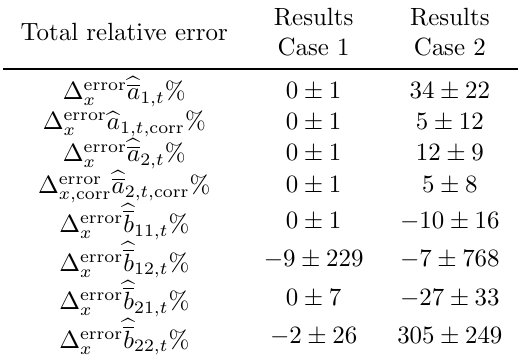
Table 2: Mean trait prediction results with true system responses corresponding to Table